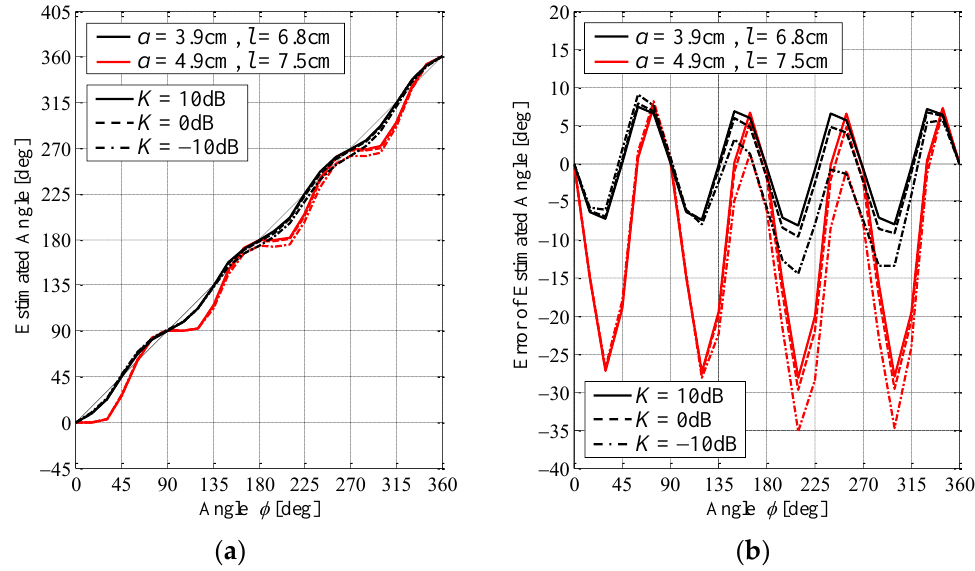
Figure 10. Estimation accuracy of the proposed antenna through Monte Carlo simulation: ( a ) estimated angle and ( b ) error of estimated angle.